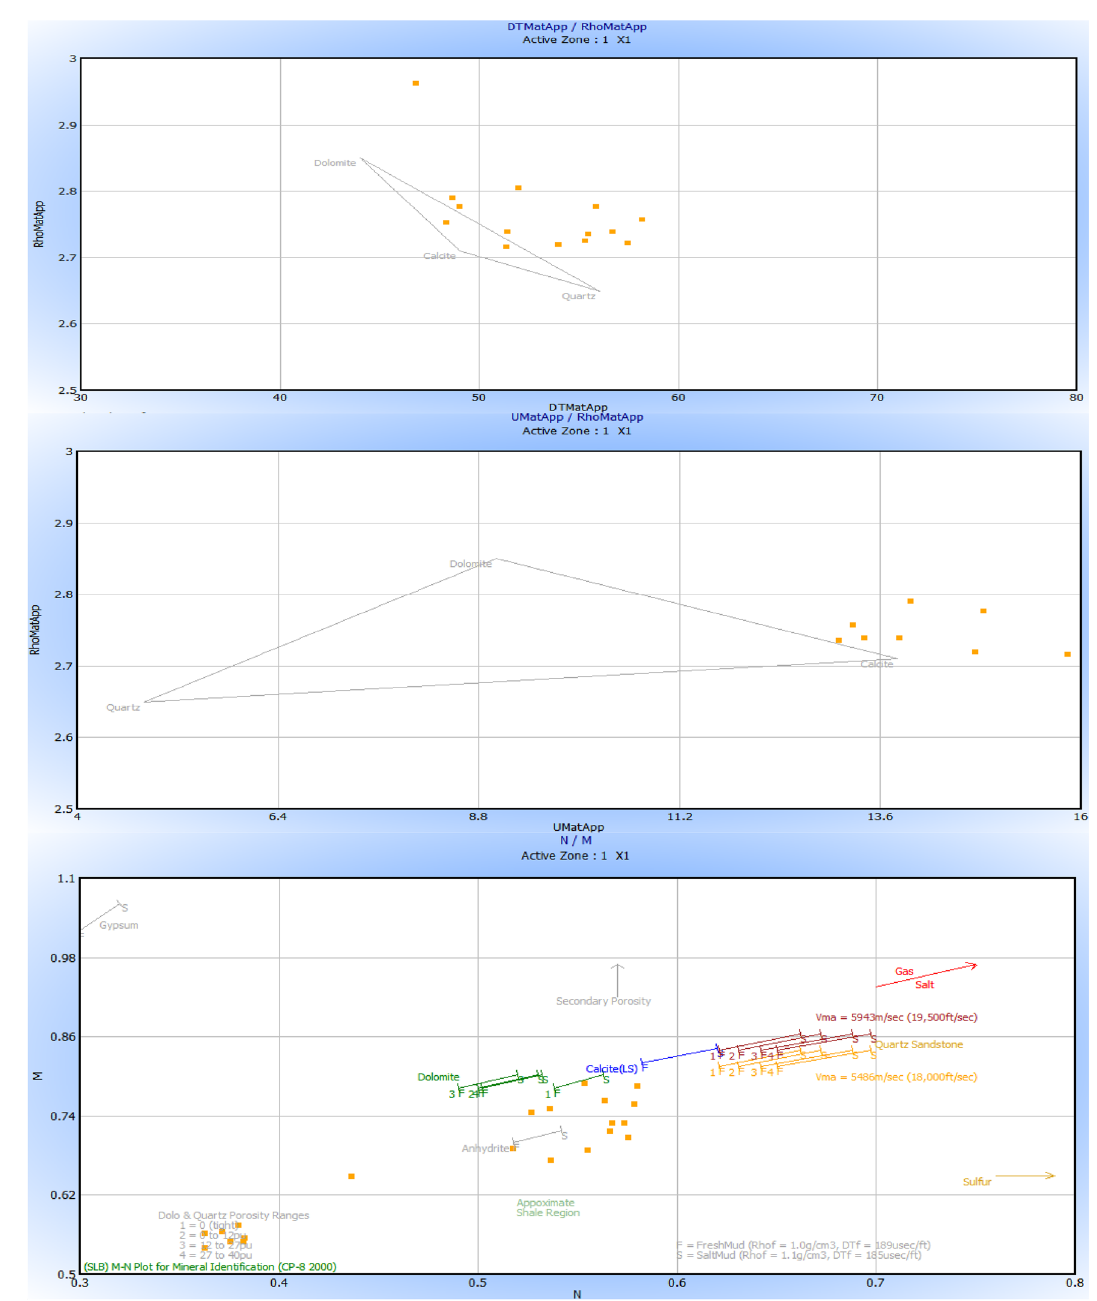
Fig. 12 MID and M–N crossplot for mineral identification for reservoir X